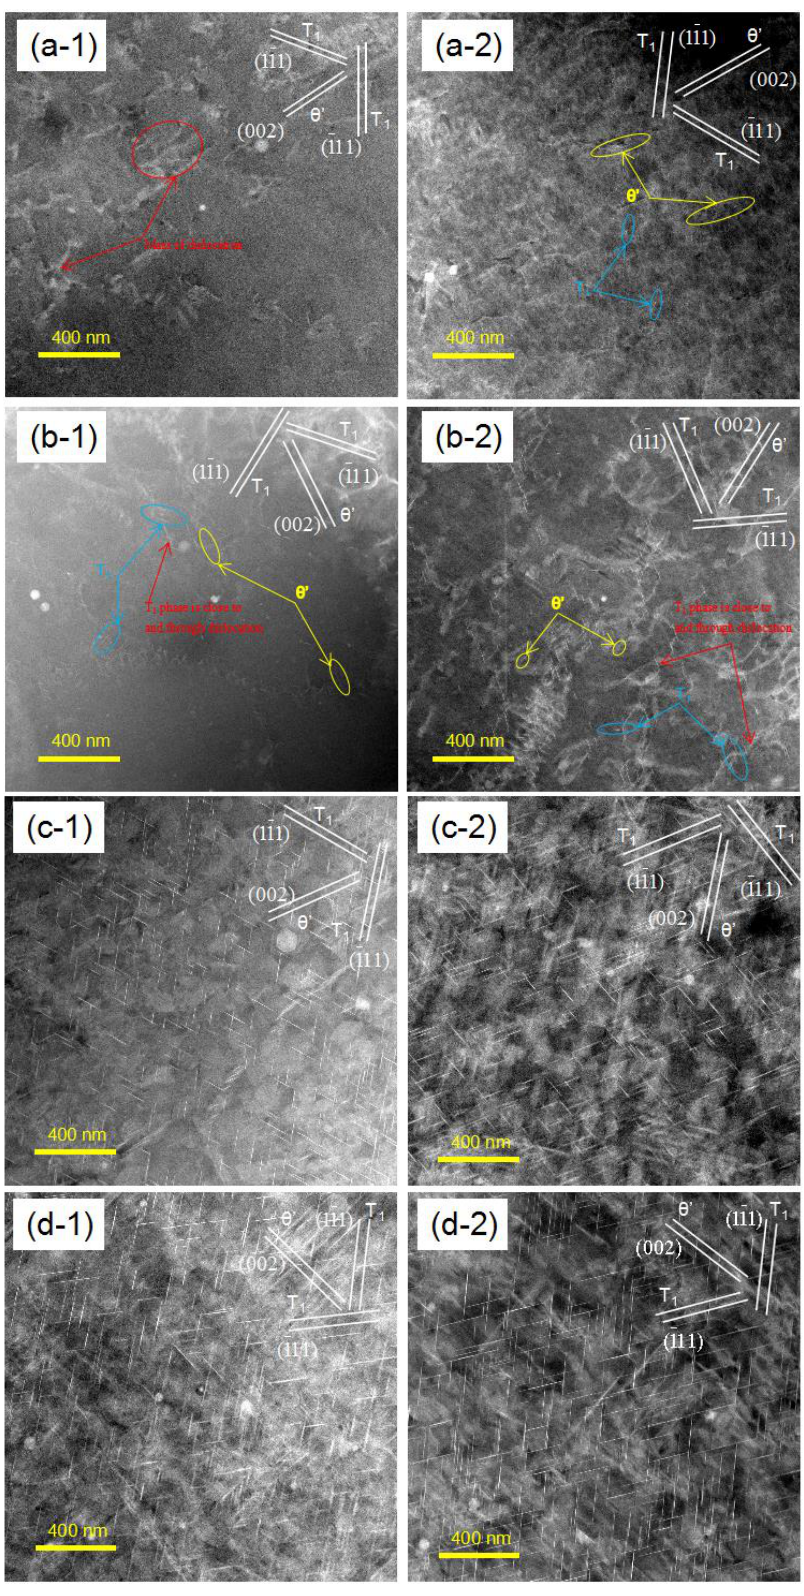
Figure 6. HAADF-STEM micro-images of Al-Li-S4 Al alloy during creep aging at 153 °C, T1 and phase evolution with time, electron beam direction approaching [110] matrix crystal axis direction; 220 MPa applied stress ( a - 1 – d - 1 ): 1 h, 10 h, 15 h, 25 h; 240 MPa applied stress ( a - 2 – d - 2 ): 1 h, 10 h, 15 h, 25 h.